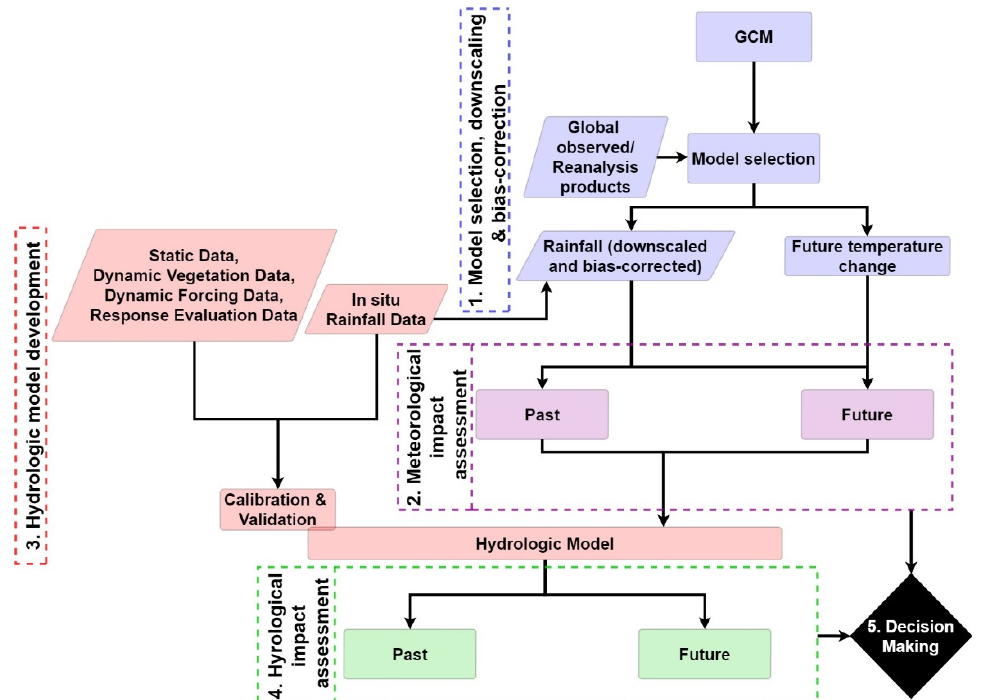
Figure 1. Research framework.